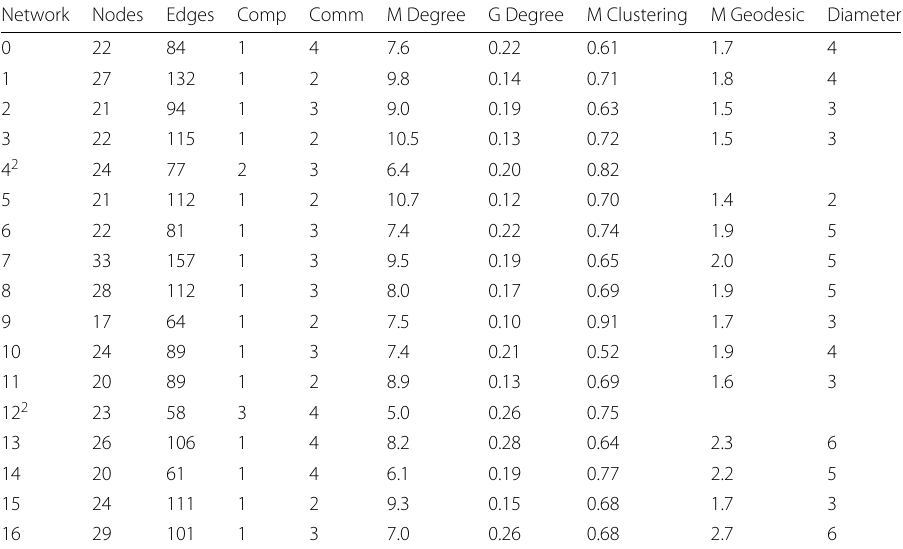
Table 2 Properties 1 of 17 networks used in simulations: Individual